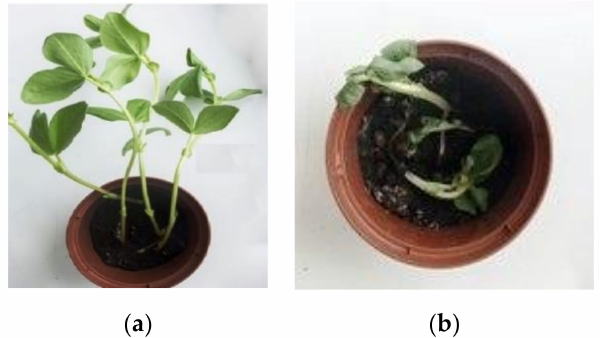
Figure 7. Comparison of the physical appearance of the bean shoots ( V í cia f á ba ): ( a ) control, ( b ) after treatment with the pesticide (acetamiprid).